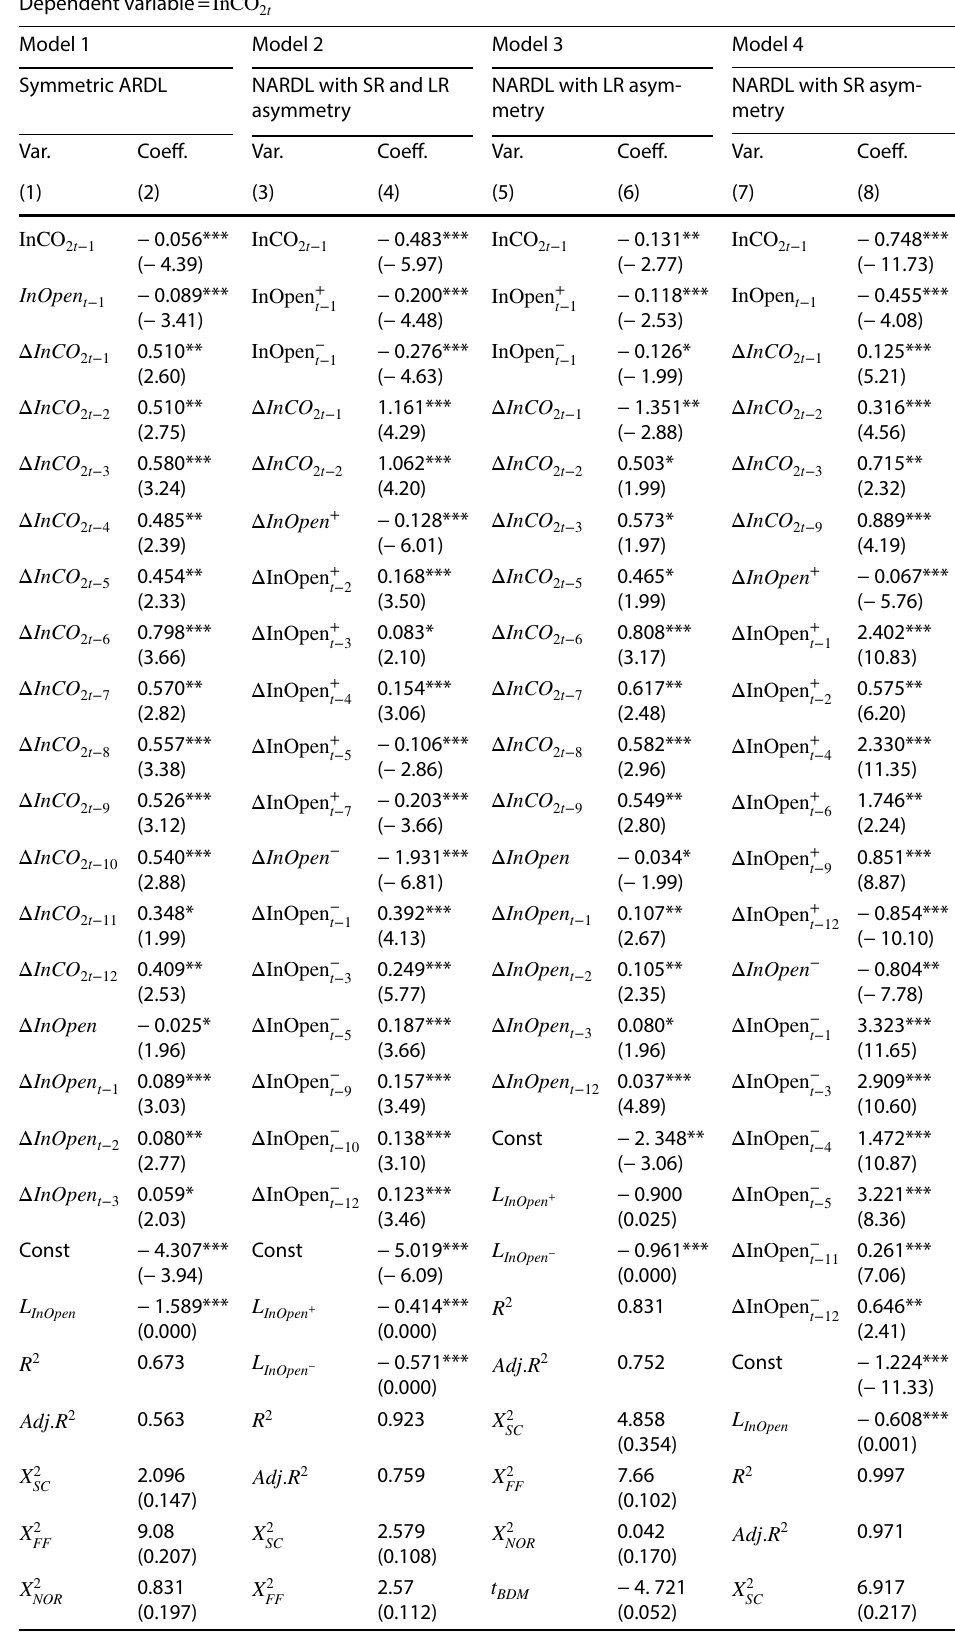
Table 6 Full-information estimates of both symmetric ARDL and nonlinear ARDL (NARDL) models